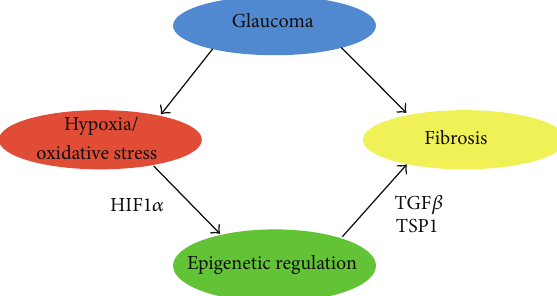
Figure 2: The potential role of hypoxia and epigenetics in the fibrosis seen in glaucoma. The hypoxic environment in glaucoma [74] may cause the epigenetic profile of the cells to change bringing about a more fibrotic phenotype [61,